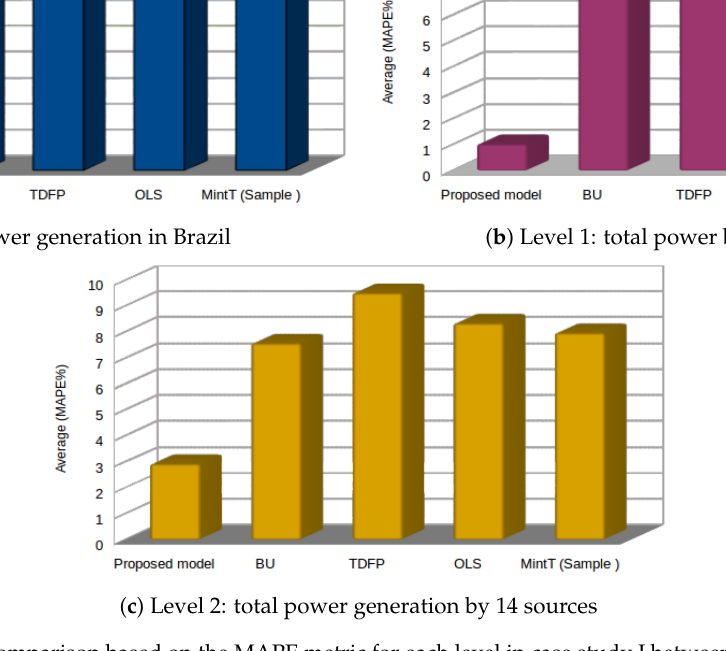
Figure 8. Performance comparison based on the MAPE metric for each level in case study I between the proposed approach and reference